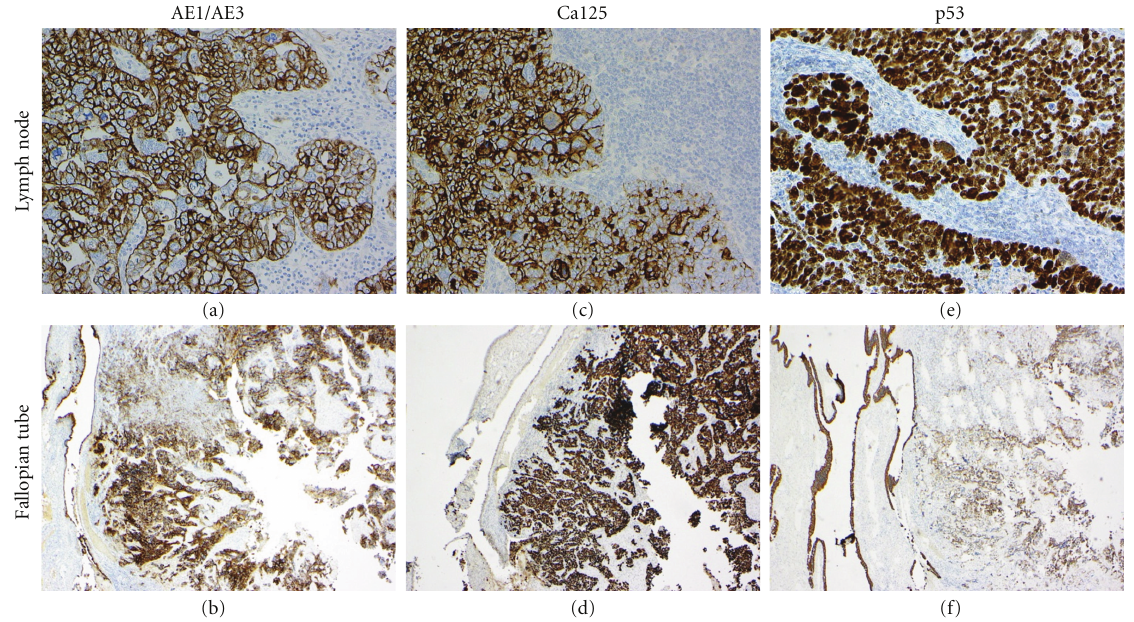
Figure 4: Membrane and cytoplasmic staining of tumour in the lymph node and the Fallopian tube with AE1/AE3 ((a) and (b)), Ca125 ((c) and (d)), and p53 ((e) and